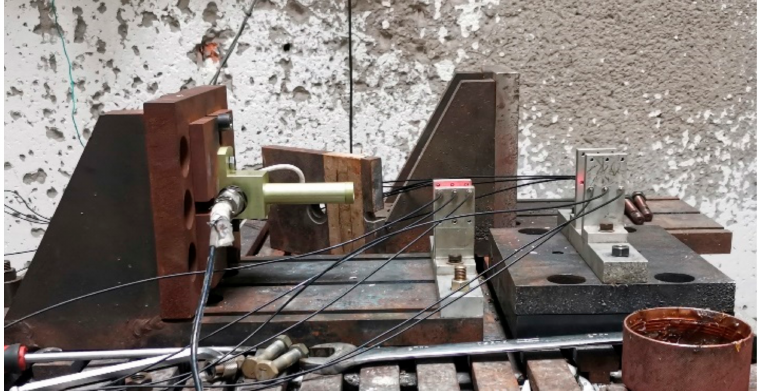
Figure 13. The test tooling of the pin-rod type of measuring device.